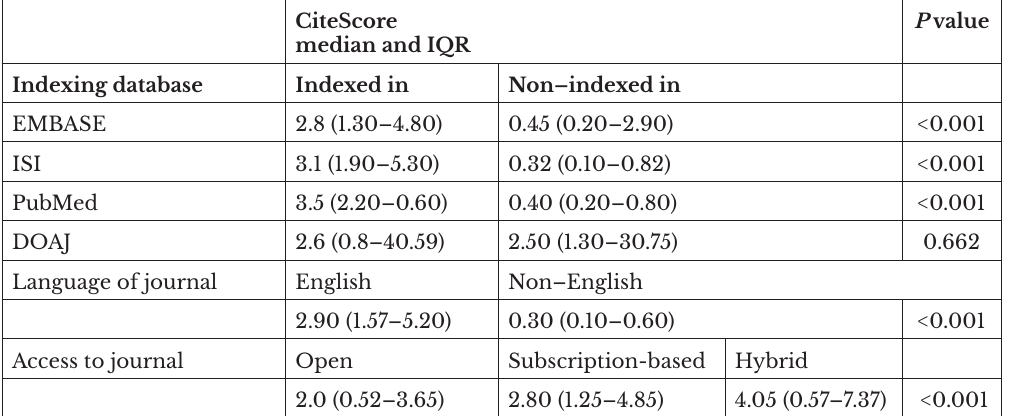
Table 3. Effects of qualitative factors on CiteScore of cardiology journals indexed in Scopus